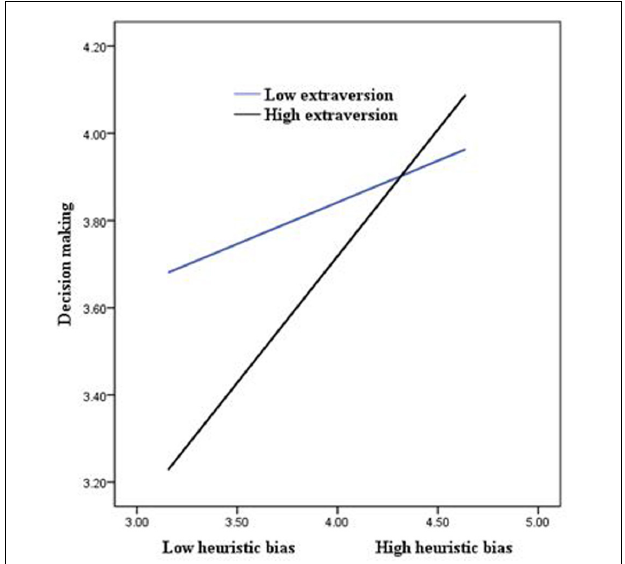
FIGURE 2 | The moderating role of extraversion in the association between heuristic bias and decision making.